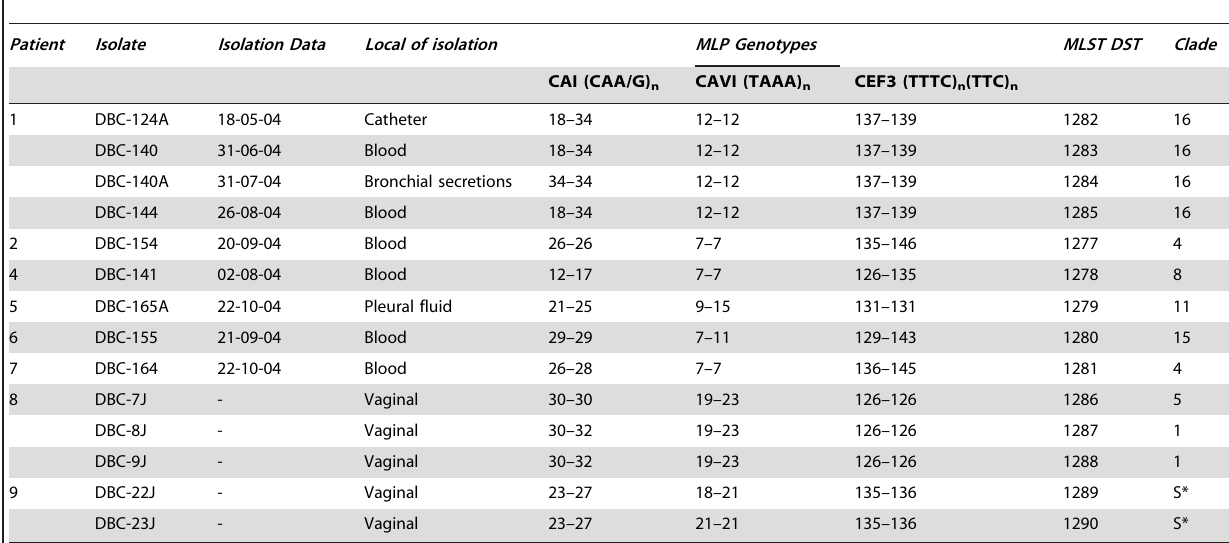
Table 1. Microsatellite genotypes and diploid sequence types (DSTs) obtained by MLP and MLST analysis of the clinical isolates used in this